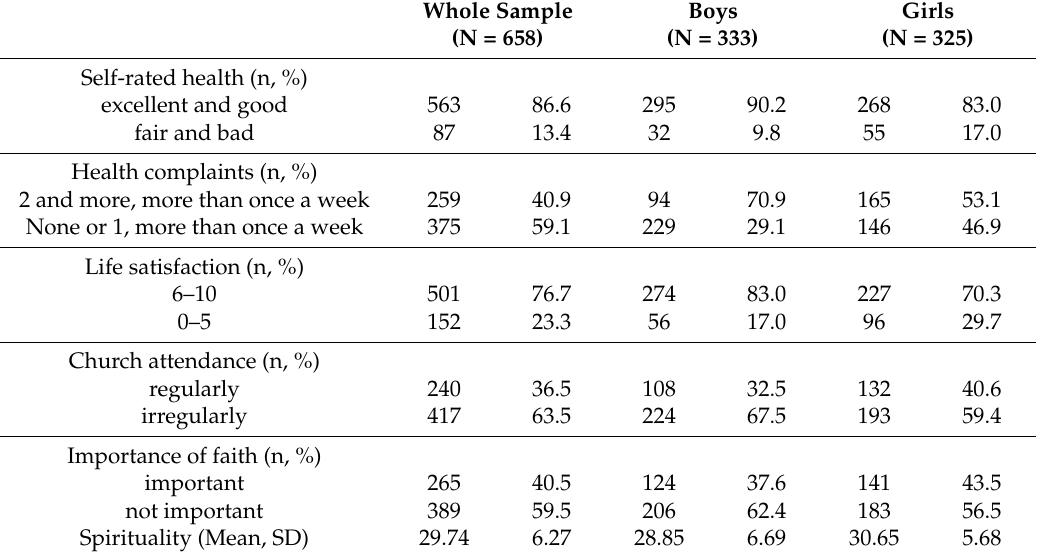
Table 1. Descriptive statistics (Mean, SD; n, %) of indicators of health, life satisfaction, spirituality, and religiosity for the whole sample and for boys and girls separately (N = 658, HBSC data collection